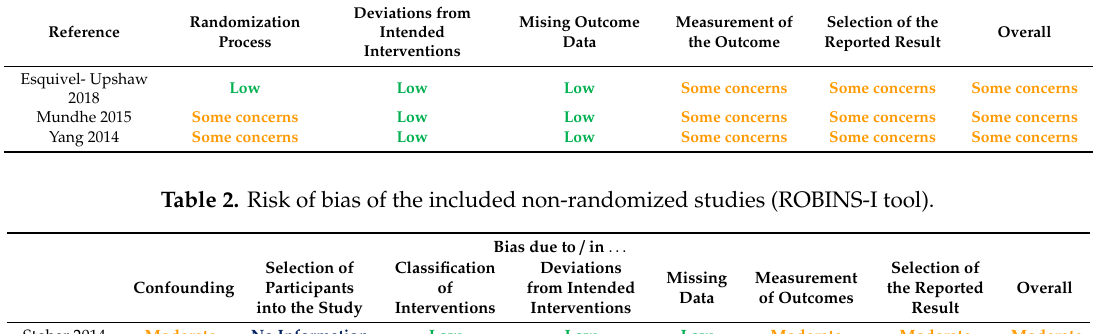
Table 1. Risk of bias of the included randomized trials (RoB 2.0 tool).